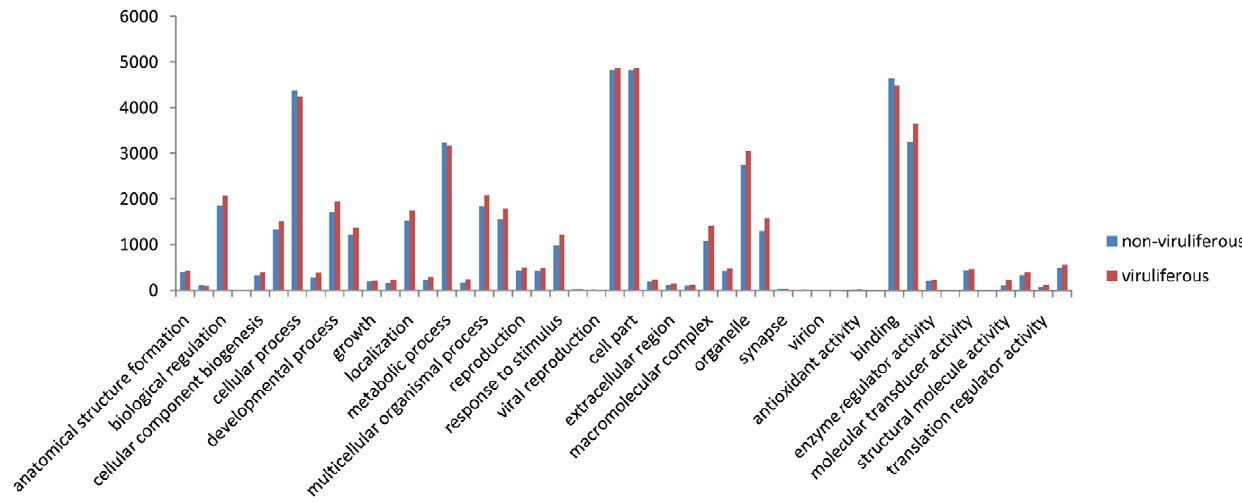
Figure 4. Comparison of GO classification of putative functions of genes from nonviruliferous and viruliferous Sogatellafurcifera samples. The x axis shows subgroups of molecular functions from GO classification and the y axis shows the number of the matched unigene sequences.